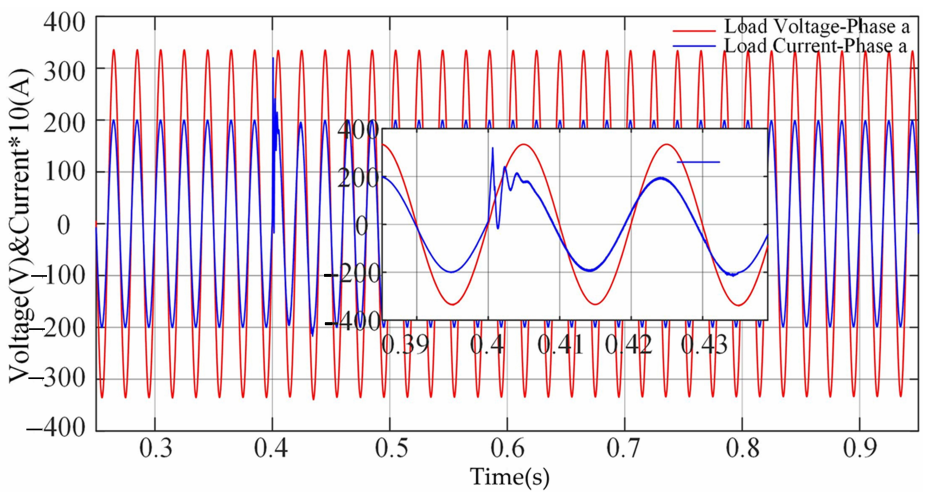
Figure 20. Variation of load voltage and current (phase-a) during the transition process.